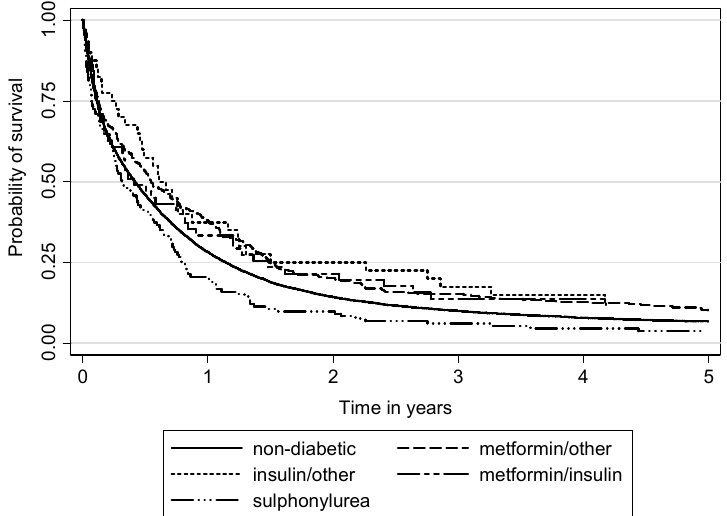
Figure2. Lungcancer-specificsurvivalbetweennon-diabeticanddiabeticpatientsbyantihyperglycemic Figure 2. Lung cancer-specific survival between non-diabetic and diabetic patients by medication user groups ( p = 0.0001). antihyperglycemic medication user groups ( p = 0.0001).